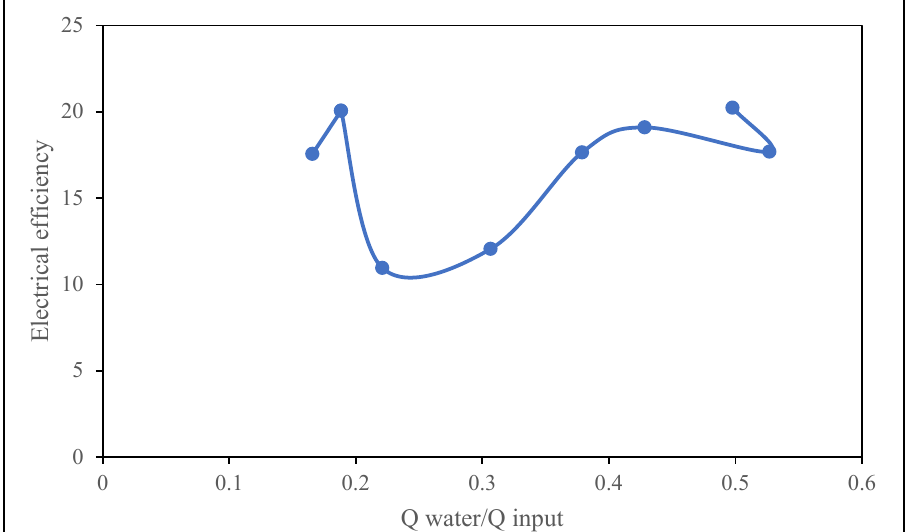
Figure 10. Electrical efficiency of PV cell.